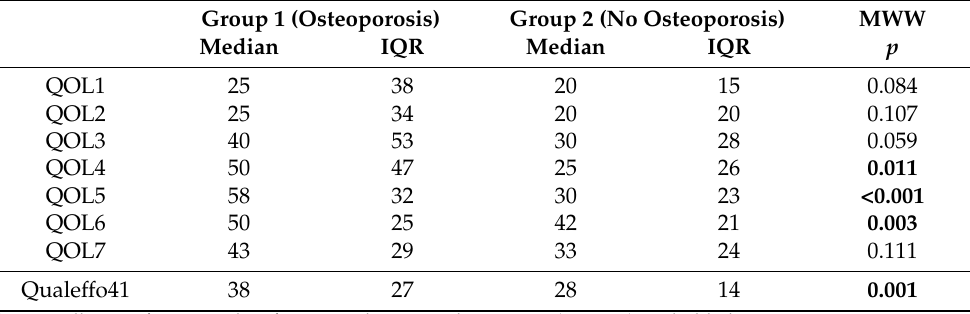
Table 2. Between-group differences in the overall quality of life and its components.